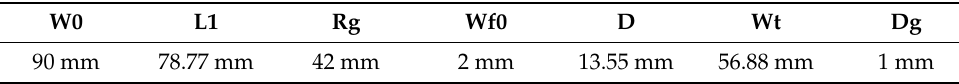
Table 3. Physical parameters of proposed slot antenna 3.